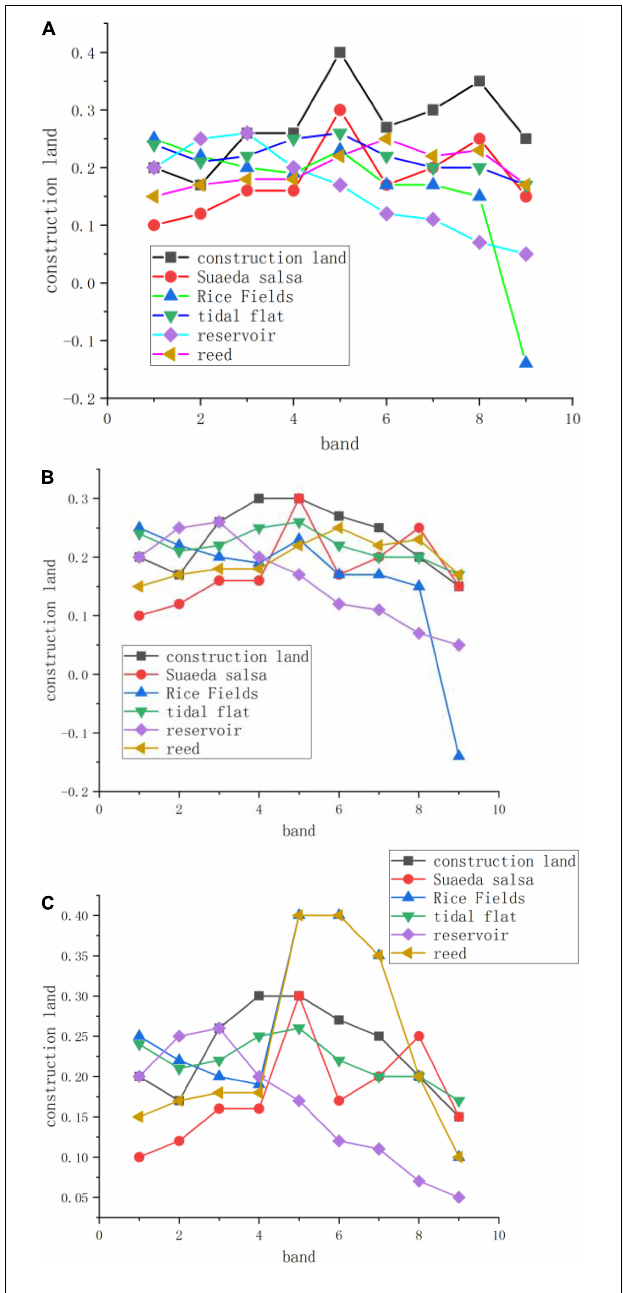
FIGURE 4 | Image feature: spectral mean of the image on (A) 15th May; (B) 15th June, and (C) 15th September.